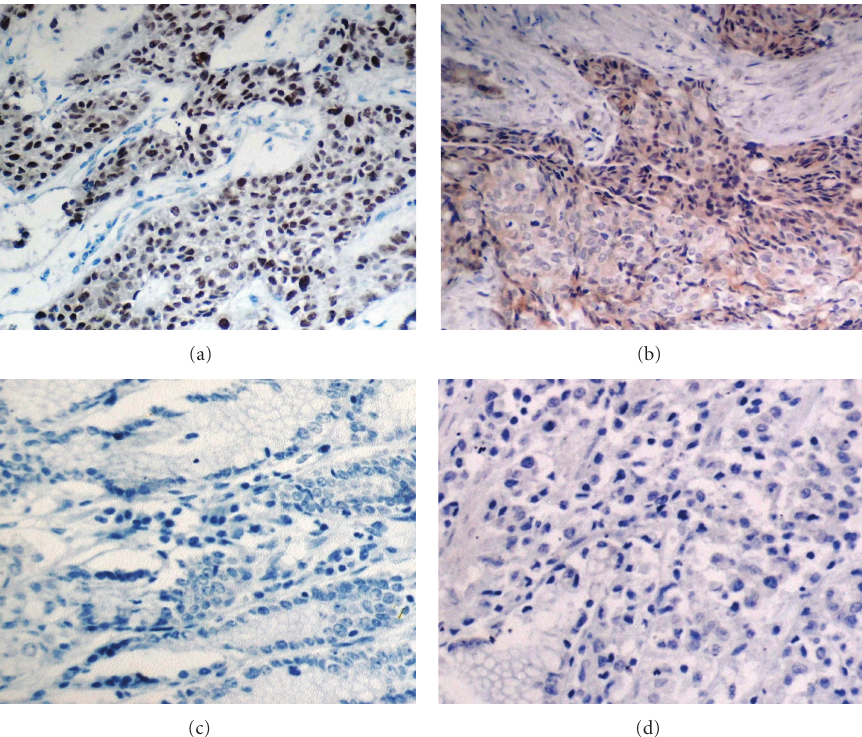
Figure 2: The protein expression of RB and TGF- β 1 by immunohistochemistry (magnification × 100). (a) Positive immunohistochemistry result of RB in para ffi n section. Expression of RB was found in nuclei of gastric carcinoma cells. (b) Positive immunohistochemistry result of TGF- β 1 in para ffi n section. Expression of TGF- β 1 was found in cytoplasm of gastric carcinoma cells. (c) Negative immunohistochemistry result of RB in para ffi n section. (d) Negative immunohistochemistry result of TGF- β 1 in para ffi n